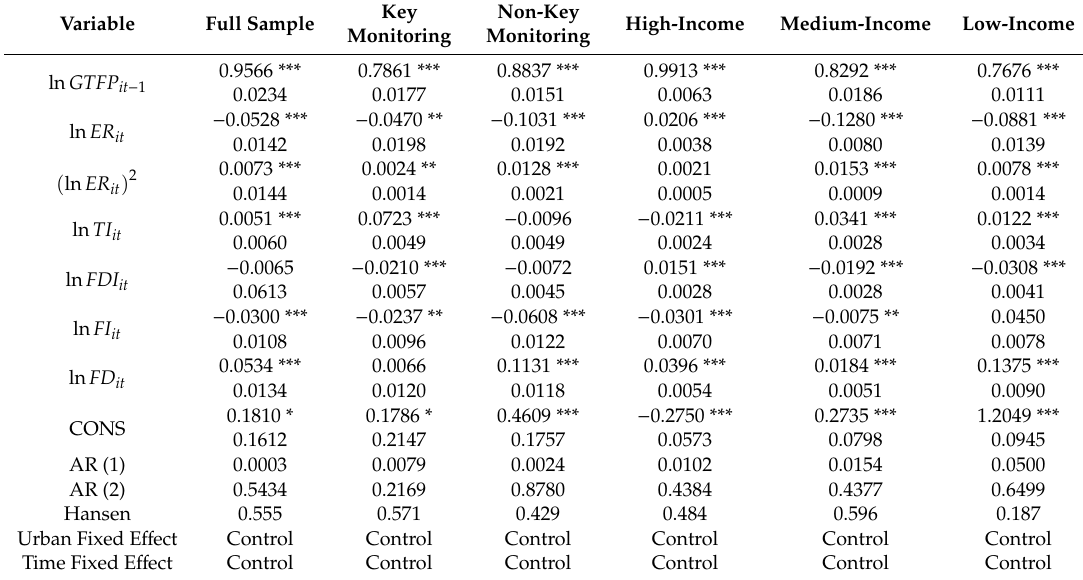
Table A2. Nonlinear relationship test results.